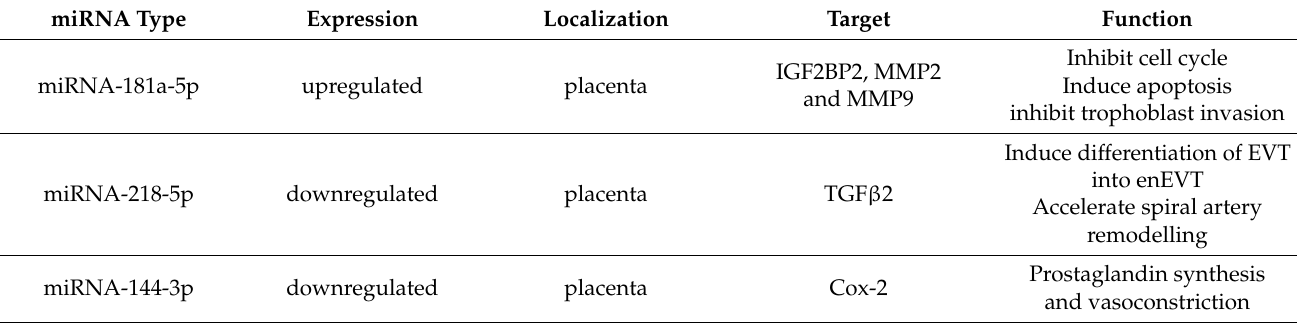
Table 1. The most common miRNA involved in PE